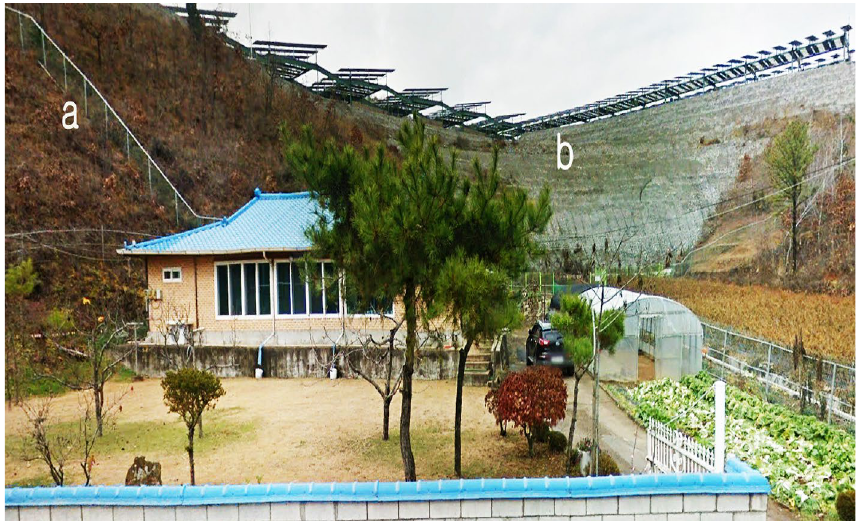
Figure 6. Typical scene of the agrophotovoltaic system observed in the experimental site, ( a ) a stair for farmers to access crops cultivated under solar panels, ( b ) cement-concrete structure converted from a mountainous landform. The fixed solar panel surroundings, captured from Google Earth street view, were obtained from Google Earth Pro 7.3.4 (https:// www. google. com/ earth/ versi ons/# earth- pro). The image created in Google Earth Pro 7.3.4 and Adobe Photoshop CS3 (https:// adobe- photo shop- cs3- update. en. softo nic. com/).